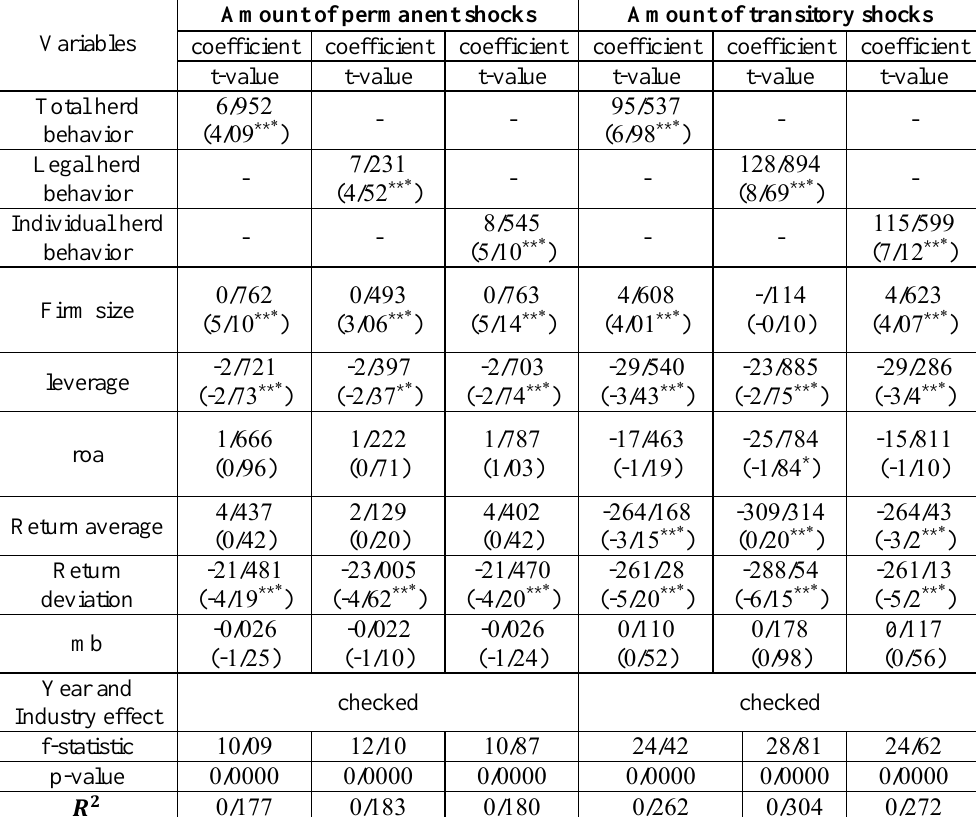
Table 2. relationship between herd behavior(total, legal, individual) and amount